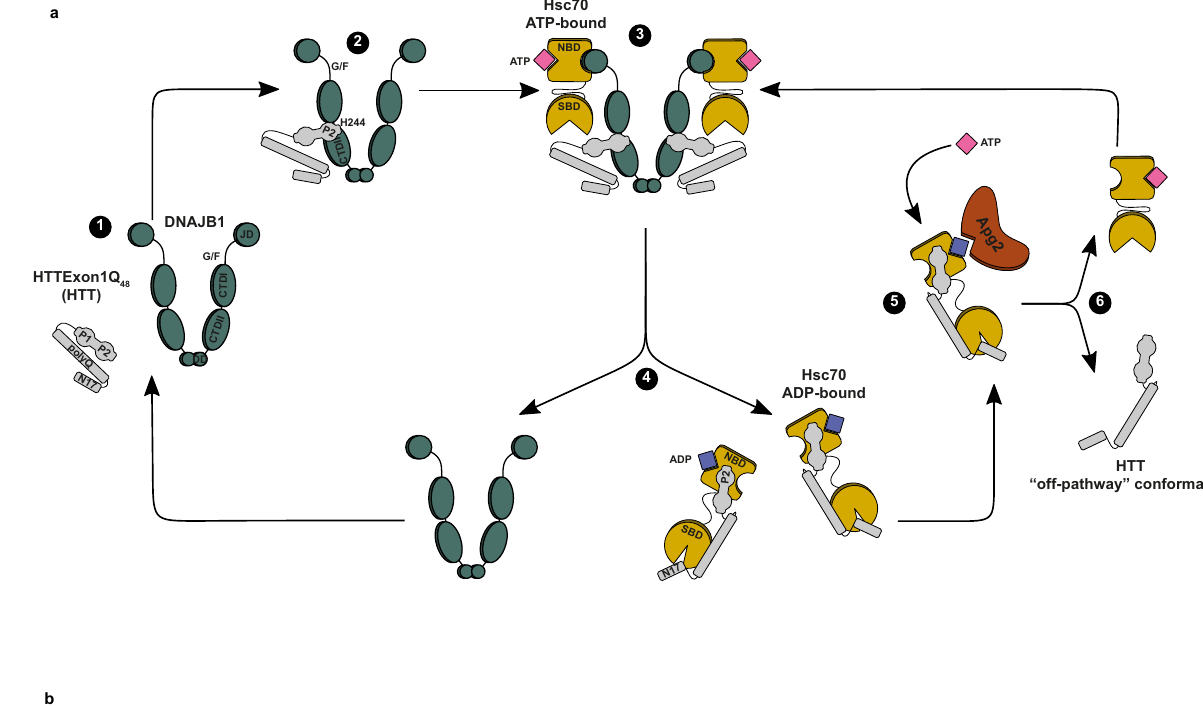
and Apg2 + ATP. DNAJB1 is depicted in teal, Hsc70 in sand, Apg2 in brown and HTTExon1Q 48 ingray.TheN17,polyQ,PRDwithP1andP2domainsofHTTExon1Q 48 are indicated on the left. The models are described in “ Discussion ”